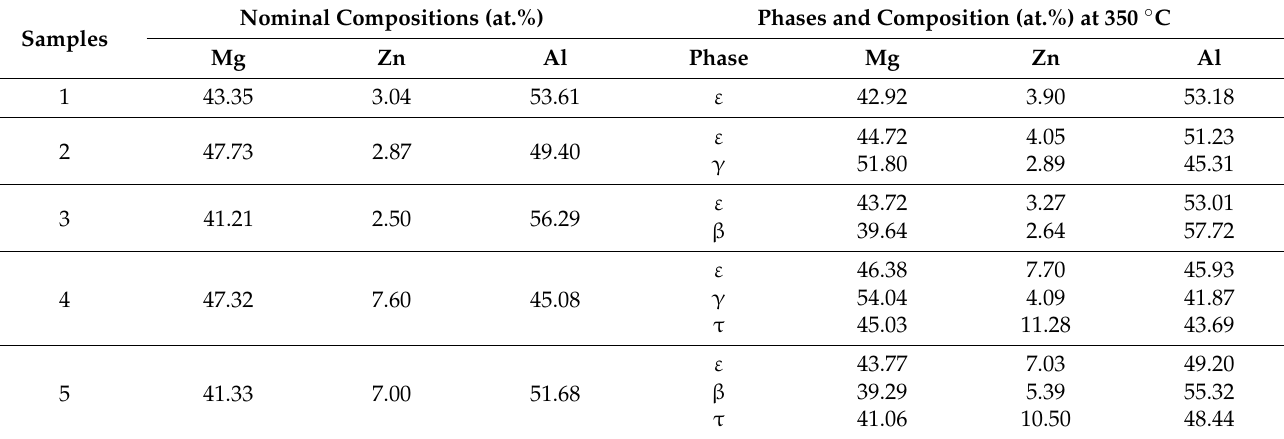
Table 1. The nominal compositions of current Mg-Zn-Al alloys and the phases constitutions and concentrations determined by XRD and